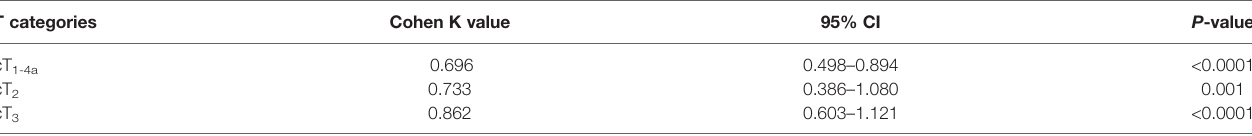
TABLE 4 | Unweighted Cohen ’ s kappa tests in the validation cohort for validating the performance of the predictive